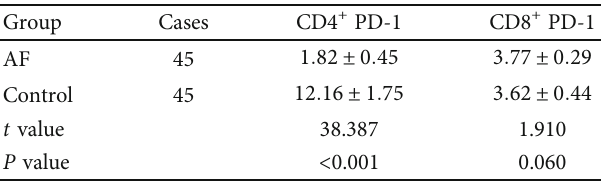
Table 3: Changes of PD-1 expression on CD4+ and CD8+ T lymphocytes in external blood of two groups ð x ± s Þ .